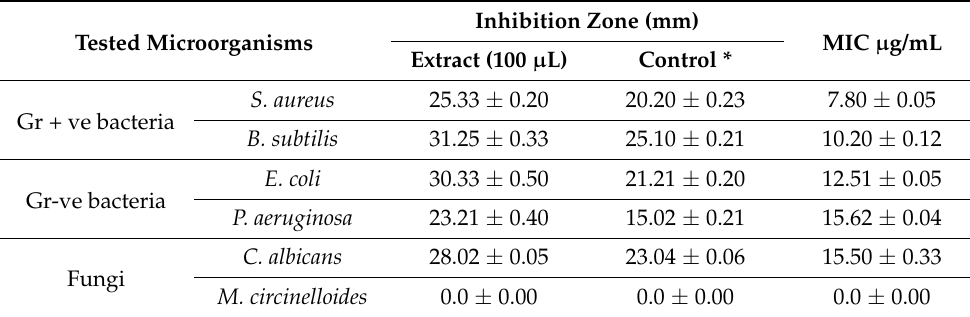
Figure 2. HPLC chromatograms of flavonoids ( a ) and phenolic ( b ) contents of latex. Table 2. Antimicrobial activity of T. peruviana latex extract against clinically important